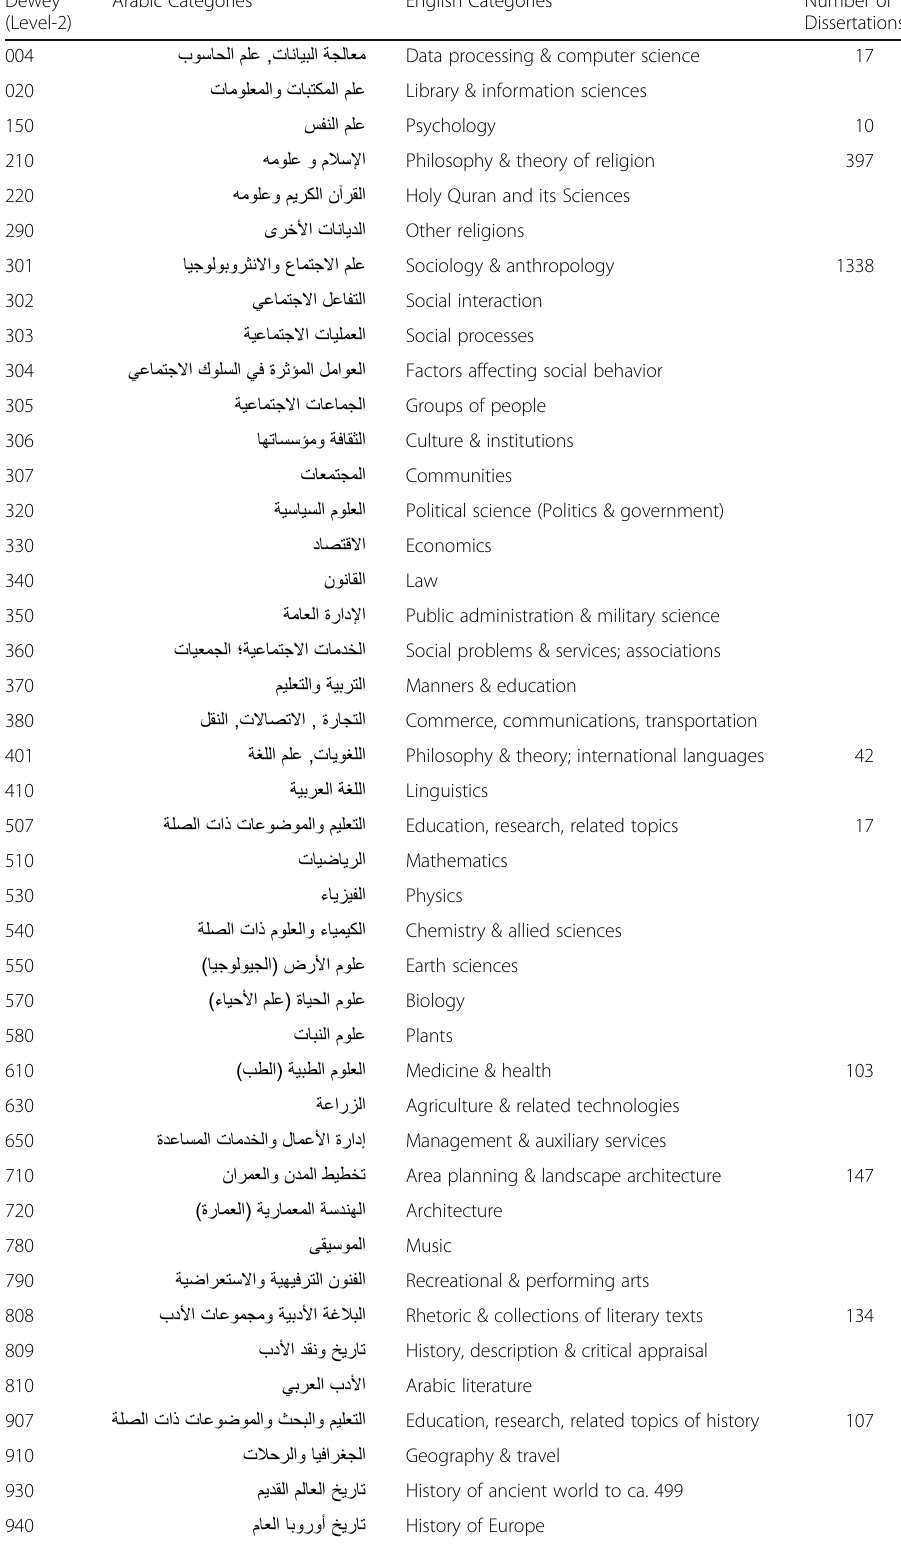
Table 5 Detailed classification of the corpus texts based on Dewey ’ s categories Dewey